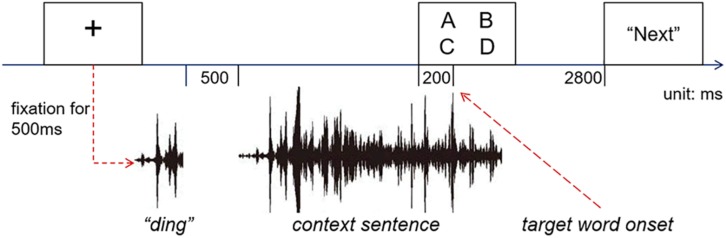
Trial structure of the experiment.